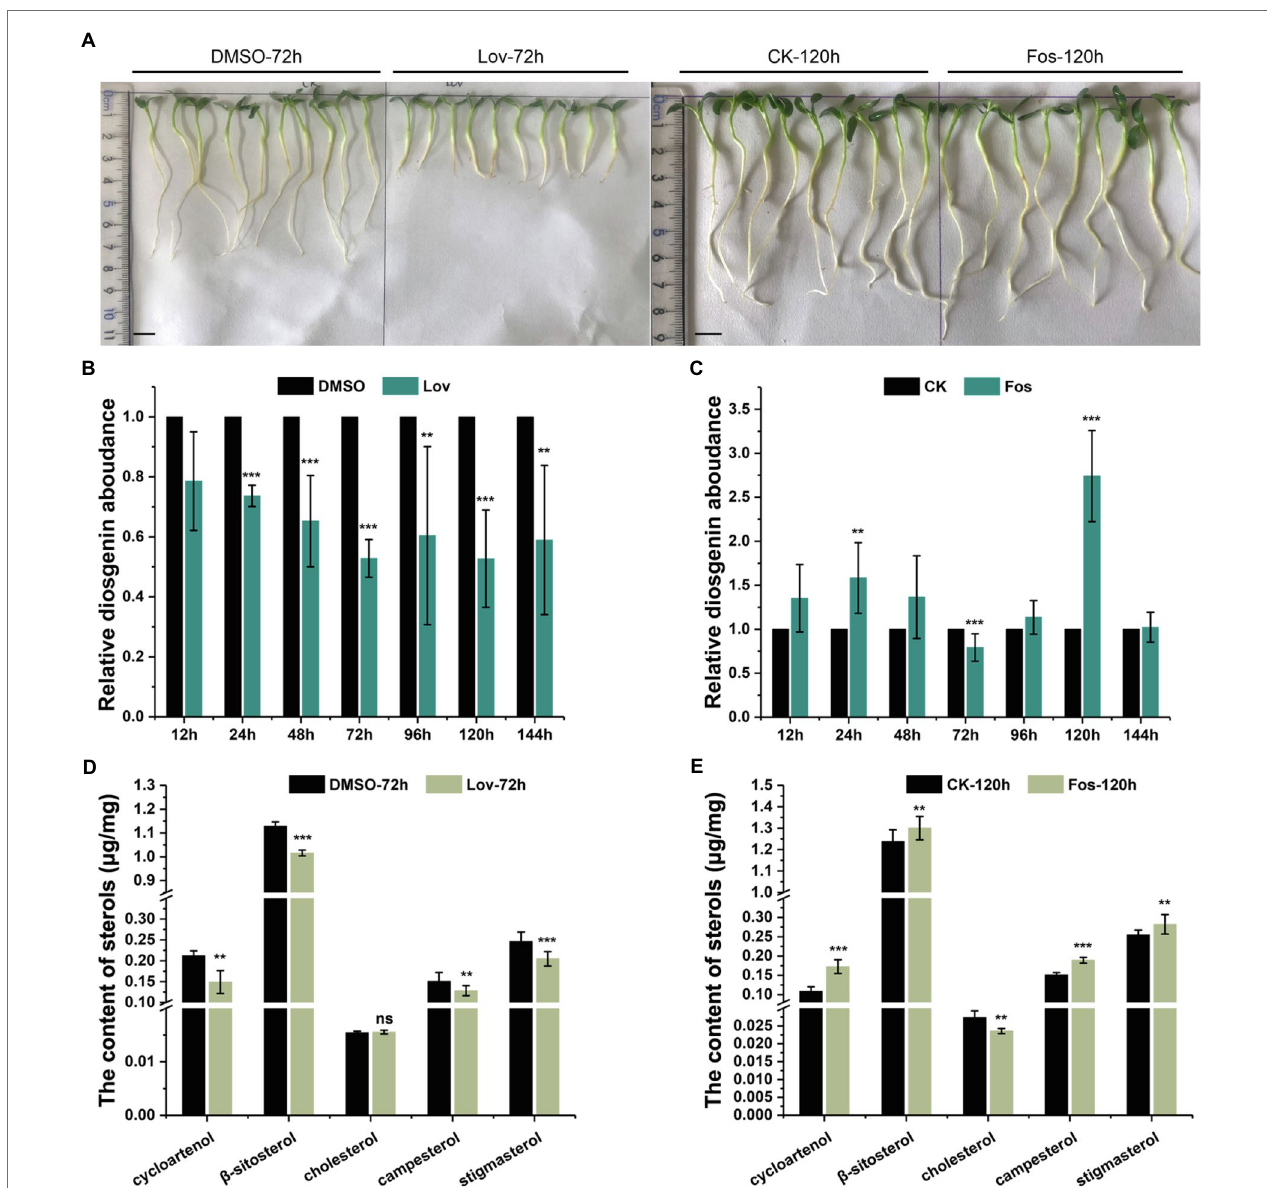
FIGURE 2 | The effects of Lov- and Fos-treatments on the root growth, and accumulation of diosgenin and several sterols of interest in T. foenum-graecum plants. (A) , representative growth phenotype of 2-day-old T. foenum-graecum seedlings treated by 100 μ m lovastatin (Lov) and the solvent control (DMSO) for 72 h, and 160- μ m fosmidomycin (Fos) and its corresponding blank control for 120 h. Scale bar = 1 cm. (B) and (C) , the effects of Lov- and Fos-treatment on diosgenin accumulation in T. foenum-graecum seedlings under different time points. Diosgenin level of each time point control was considered as a value of 100%, and relative diosgenin abundance in the Lov- or Fos-treated plants was expressed as ratios to that of the control. (D) and (E) , the effects of Lov-72-h- and Fos- 120 -h-treatments on the accumulation of cycloartenol, cholesterol, and several 24-alkyl sterols ( β -sitosterol, campesterol, and stigmasterol). Data represent the averages of three biological repeats and error bars designate s.d. (** p < 0.05 and *** p < 0.01; ns, not significant by one-way